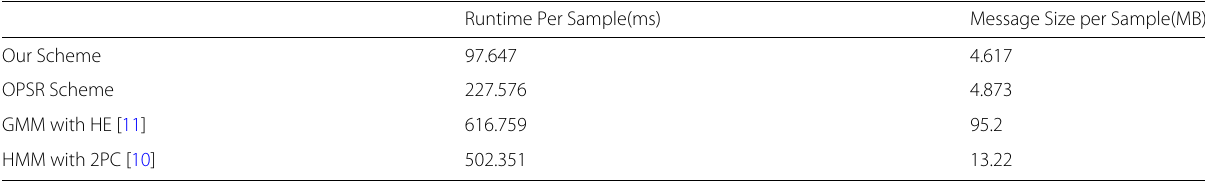
Table 7 Comparison of runtime and message size with other